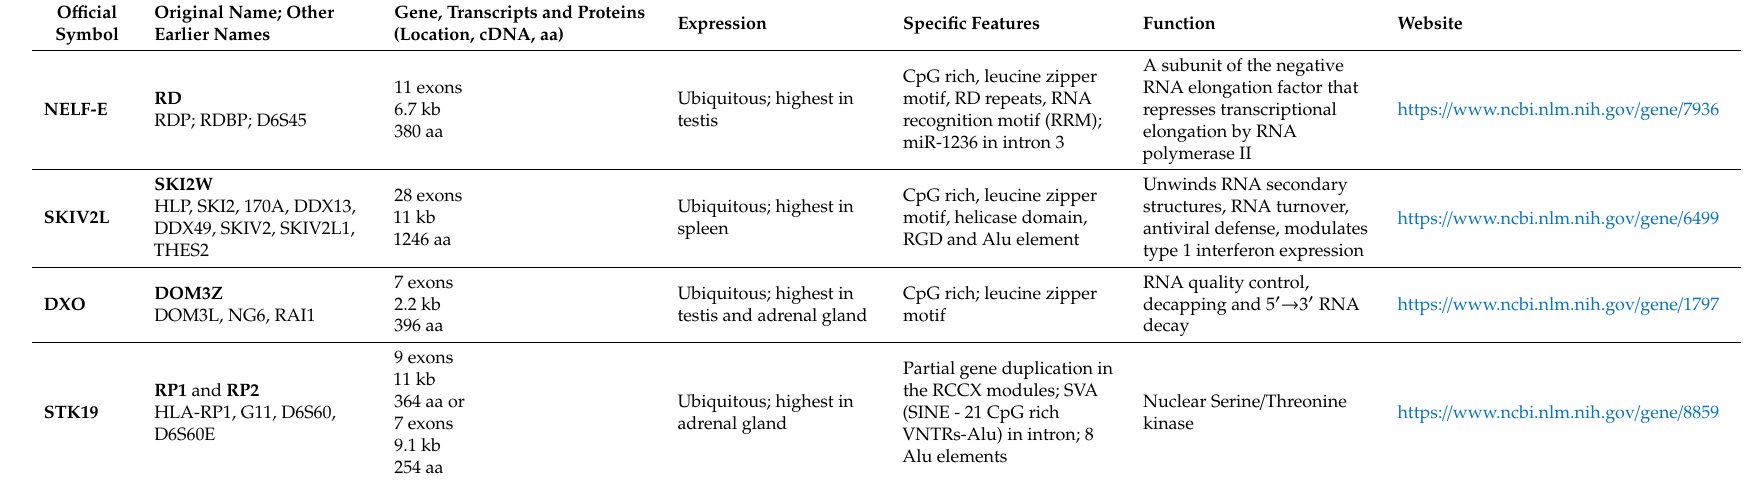
Table 1. Characteristics of the NSDK genes for RNA metabolism and surveillance quartet in the class III region of the human major histocompatibility complex. O ffi cial